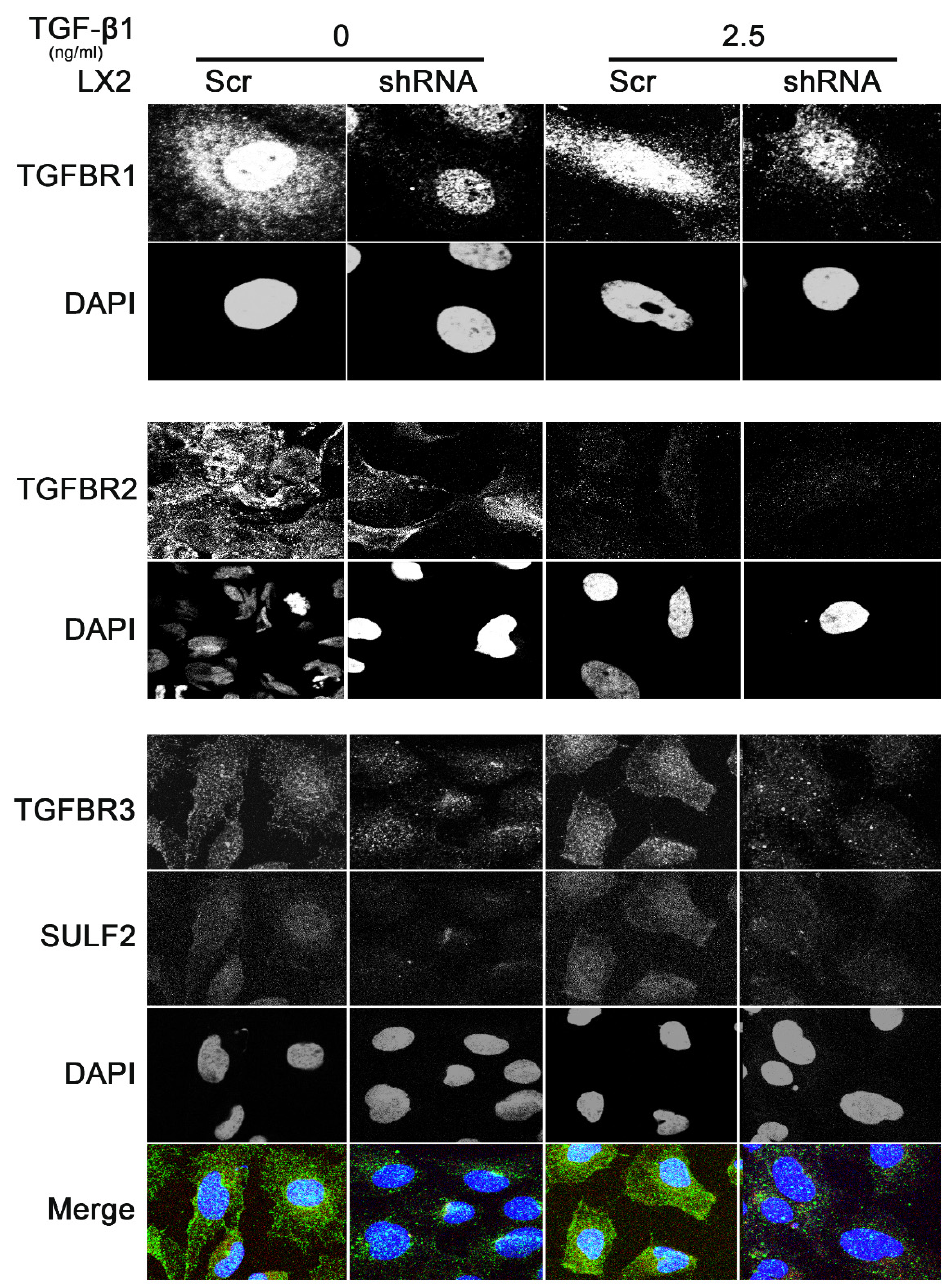
Figure 6. Immunofluorescence analysis of the effect of SULF2 on TGF- β receptors in human hepatic stellate cells (20×). The expression of TGFBR1 (top row in panel 1); TGFBR2 (top row in panel 2); TGFBR3 and SULF2 (top and bottom row, respectively in panel 3) after TGF- β 1 treatment. SULF2 decreased the expression of TGFBR1, 2 and 3 and co-localized with TGFBR3. HSCs were incubated in 1% FBS for 24 h prior to the addition of TGF- β 1 (2.5 ng/mL). Experiments were performed in triplicate. Representative micrographs are shown.